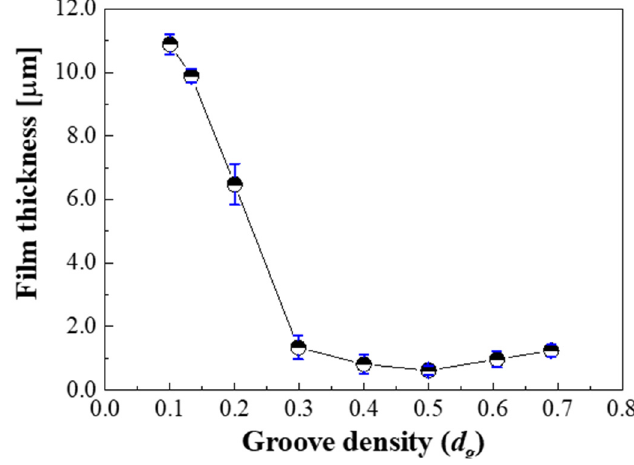
Figure 10. Film thickness as a function of groove density.